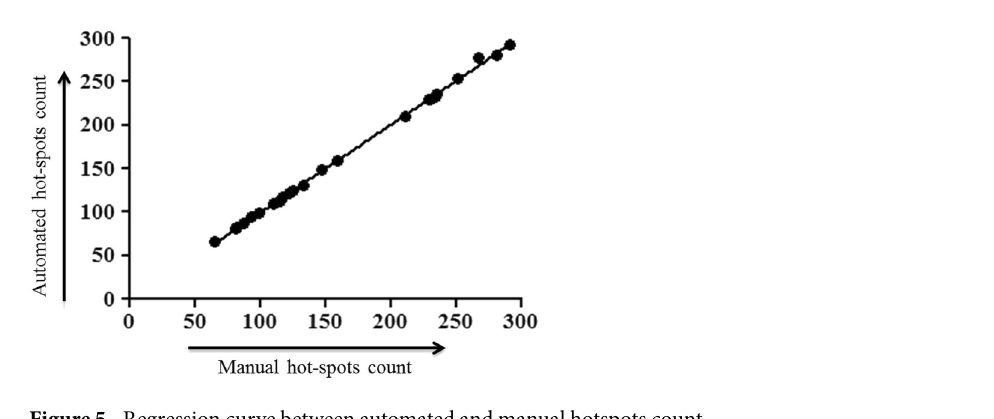
Figure 5. Regression curve between automated and manual hotspots